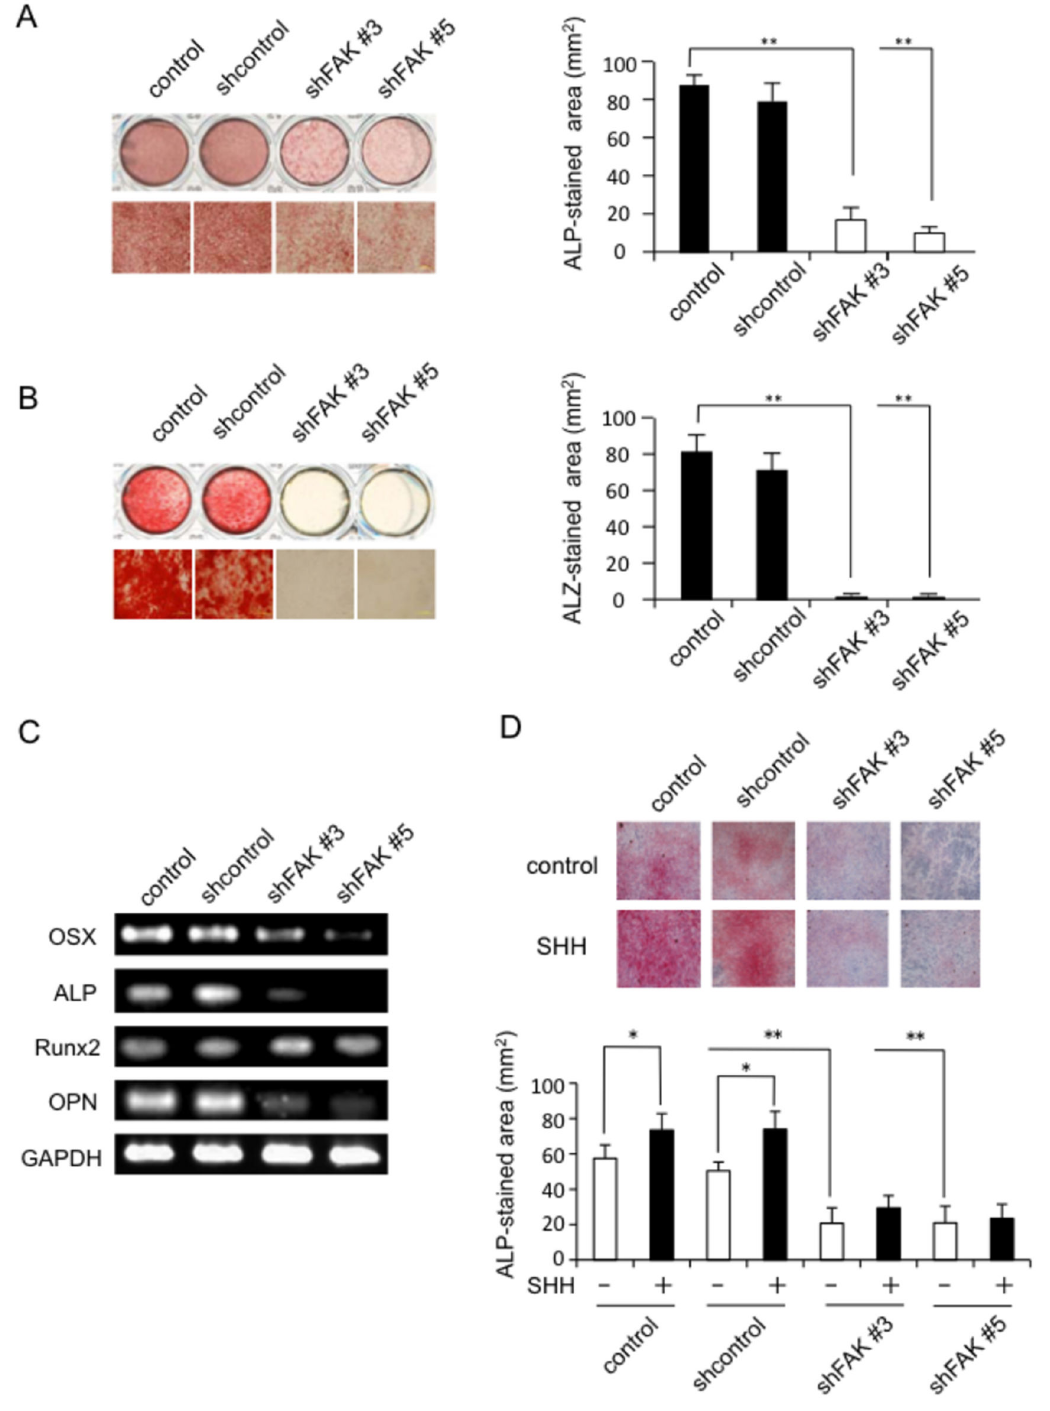
Figure 6. Effect of shFAK and SHH on MC3T3-El cell differentiation. A, Suppression of ALP staining in shFAK-infected MC3T3-El cells (n = 5). B, Suppression of Alizarin red staining in shFAK-infected MC3T3-El cells (n = 5). C, RT-PCR analysis of osterix (OSX), ALP, Runx2, and osteopontin (OPN) mRNA expression in control and shFAK-infected MC3T3-El cells. D, Effect of SHH on the ALP staining of shFAK-infected MC3T3-El cells (n = 5). The data from a typical experiment are presented: similar results were obtained in three separate experiments. Data present mean ± SD. Statistical significance was defined as * P < 0.05 and ** P < 0.01. doi: 10.1371/journal.pone.0076785.g006 PLOS ONE |